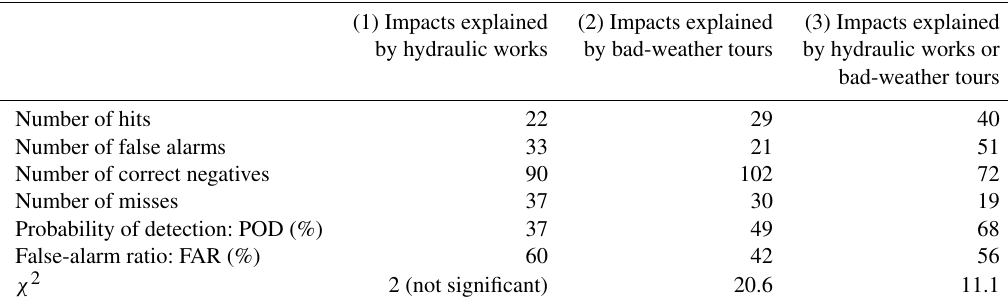
Table 6. Performance criteria assessing the predictive power of the presence of hydraulic works or bad-weather tours in identifying sections with proven